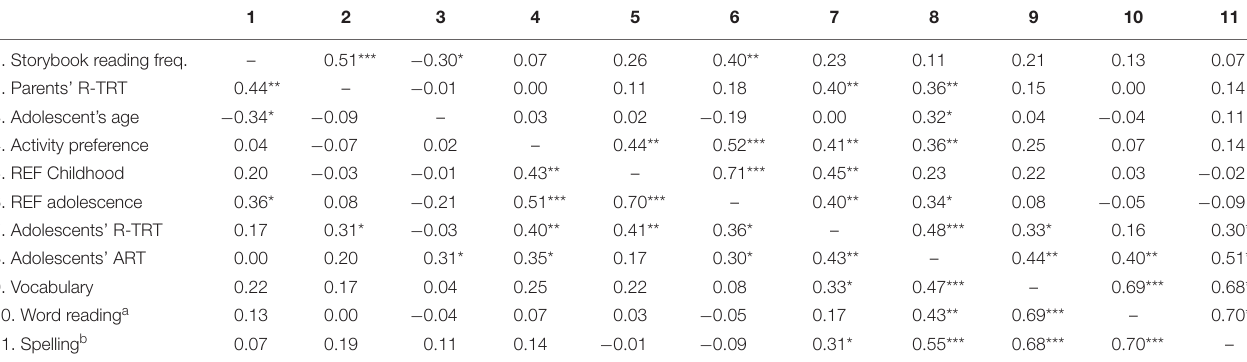
TABLE 2 | Correlations and partial-correlations between parent and adolescent measures.